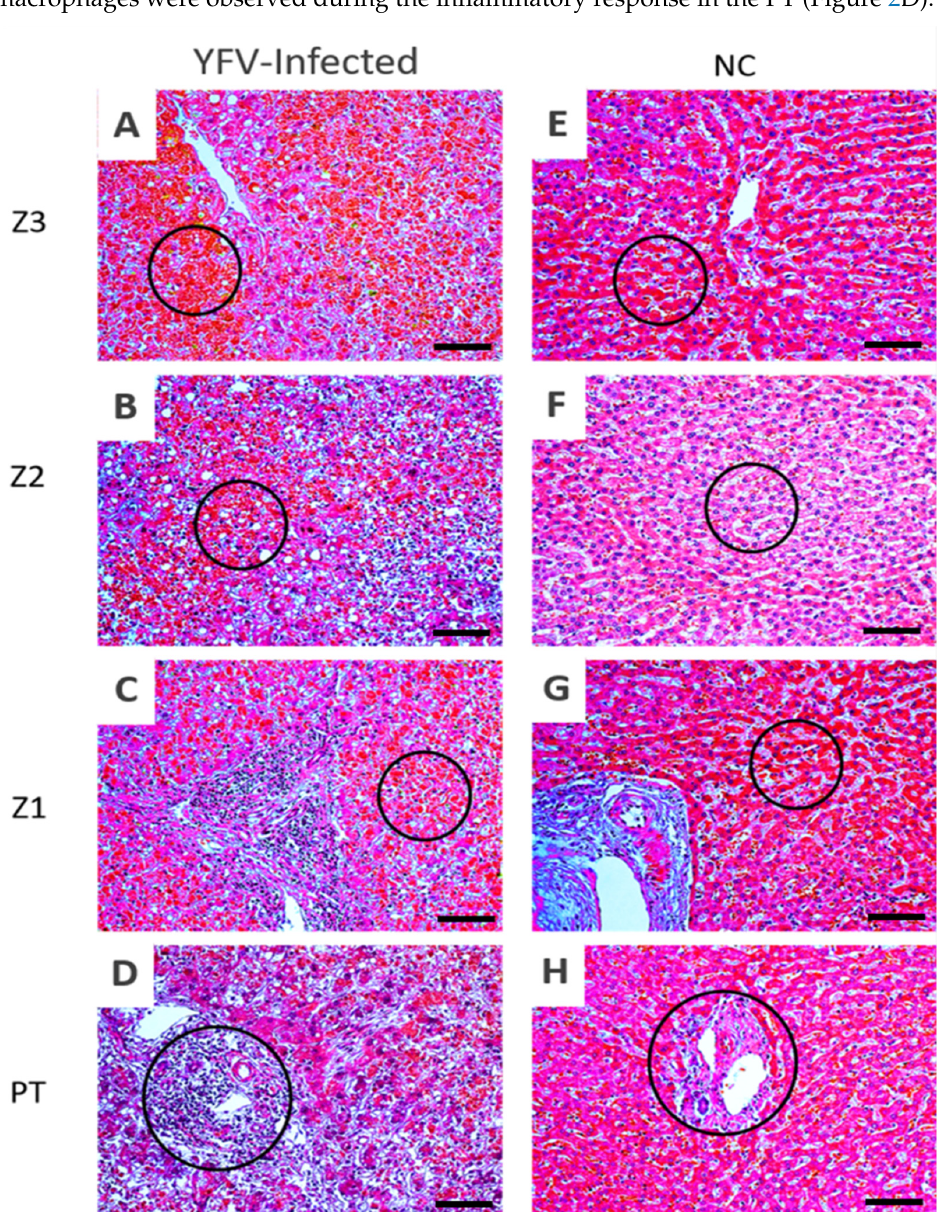
Figure 2. Histopathological analysis of the acinar zones in the liver of humans with fatal yellow fever and normal controls (NC). Z3, Z2, Z1, and PT in the hepatic parenchyma of fatal cases affected by YFV and NC. ( A – D ) Necrotic areas with haemorrhagic foci in A-Z3, B-Z2, and C-Z1 (black circles) characterised by areas of presence of red blood cells and absence of nuclei with the presence of cell debris. The massive presence of inflammatory infiltrates in the PT (black circle) D-PT. ( E – H ) Preservation of the hepatic parenchyma (Z3, Z2, Z1, and PT) in NC cases (black circles) E-Z3, F-Z2, G-Z1, H-PT. Z3: centrolobular zone; Z2: midzonal zone; Z1: periportal zone; PT: portal tract. NC: normal control. 400 × magnification (scale: 20 µ